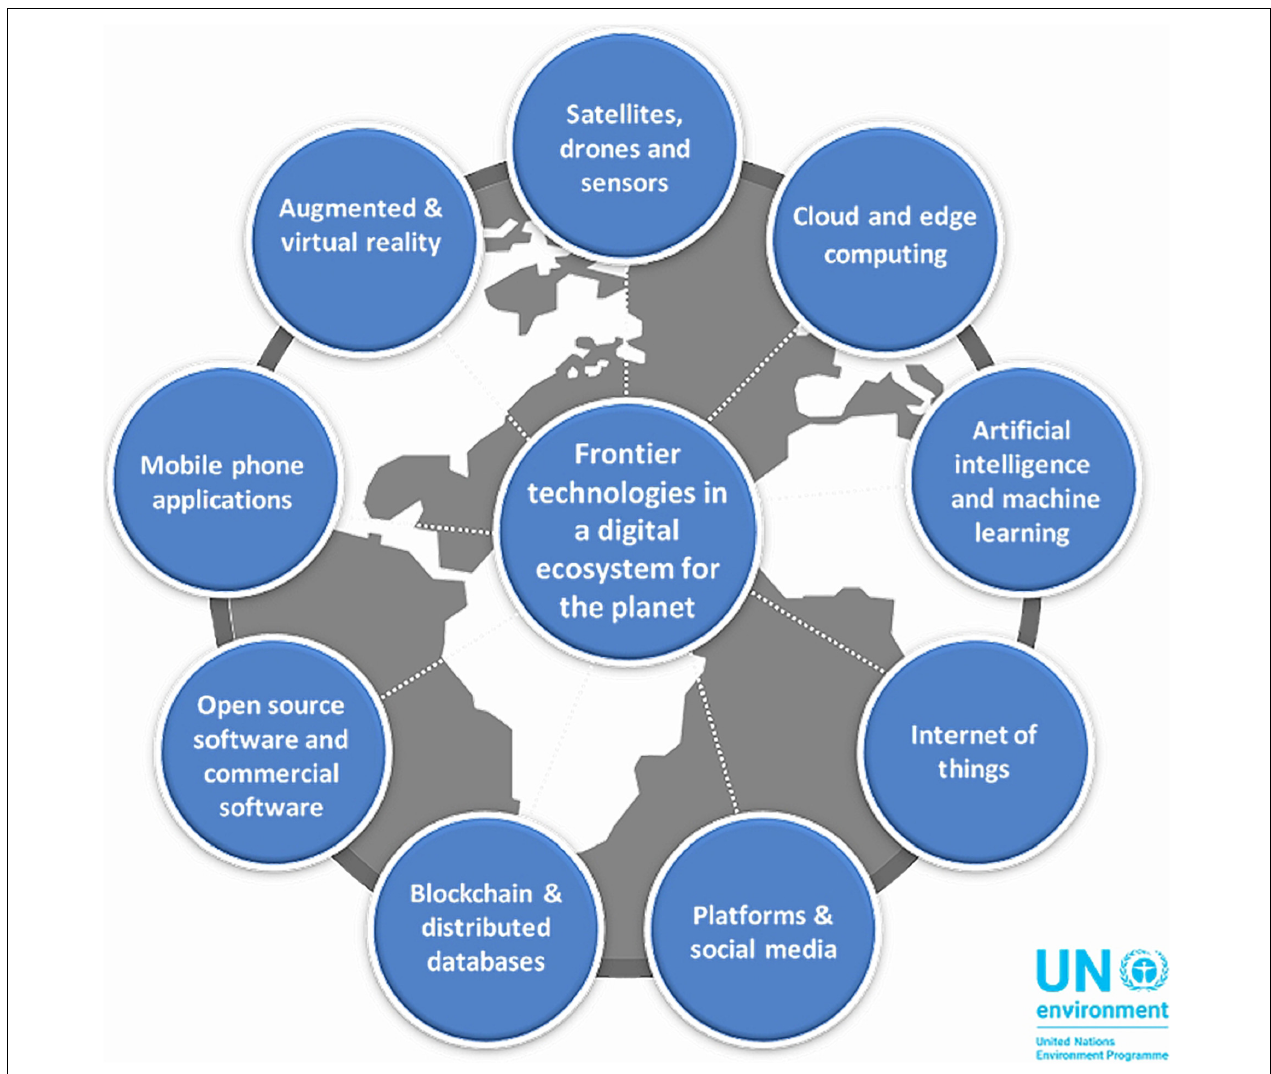
FIGURE 5 | Citizen science activities are embedded in the emerging digital technologies for the monitoring of natural resources and anthropogenic impact on the environment (from Jensen et al., 2019; Courtesy of UN Environment